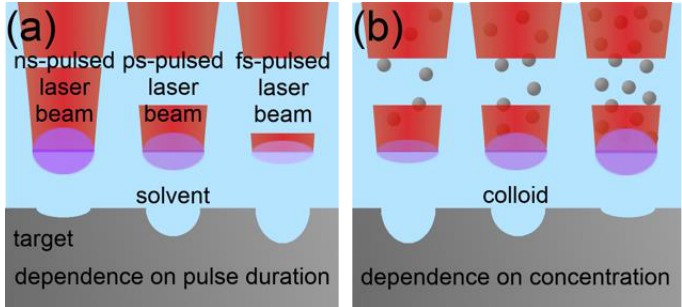
Figure 9. Illustration of the optical breakdown of the liquid during the laser ablation of metals in liquids at different intensities neglecting non-linear effects. Dependence of the occurrence of the optical breakdown on the laser pulse duration ( a ) and on the colloid concentration ( b ). Reprinted with permission from [66].